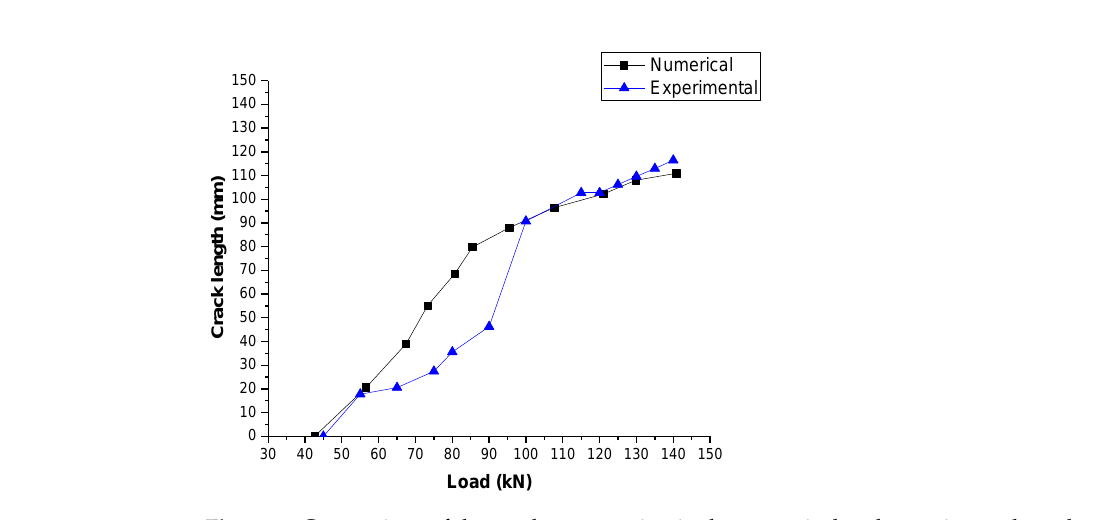
Table 4. Loss of prestress in railway sleepers due to time-dependent